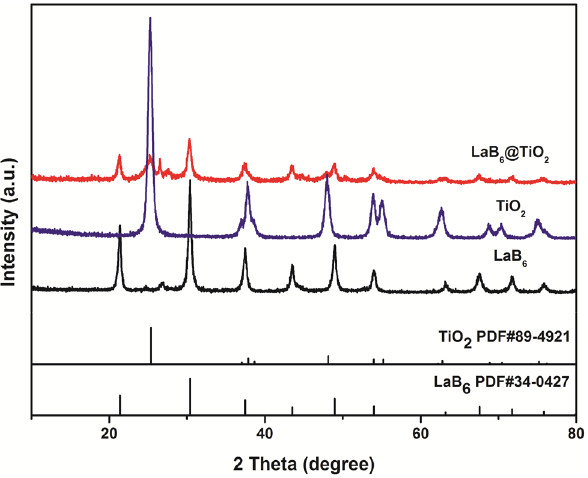
Figure 2: XRD patterns of LaB 6 , TiO 2 , and LaB 6 @TiO 2